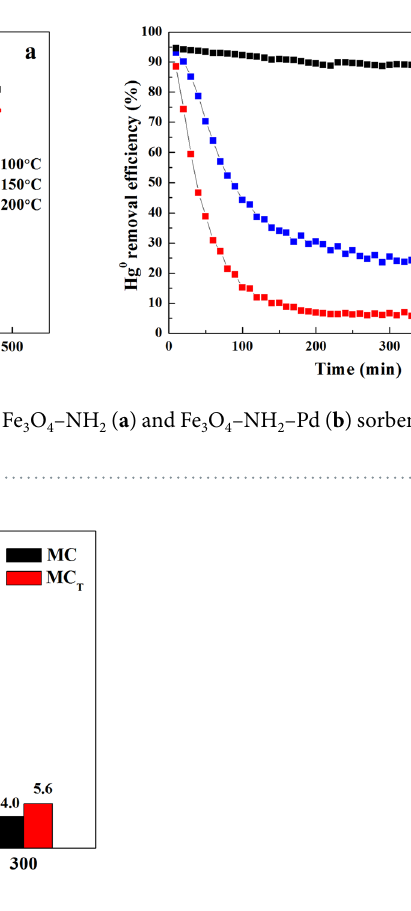
Figure 3. Mercury capacity and theoretical adsorption capacity of mercury of Fe 3 O 4 -NH 2 -Pd at different